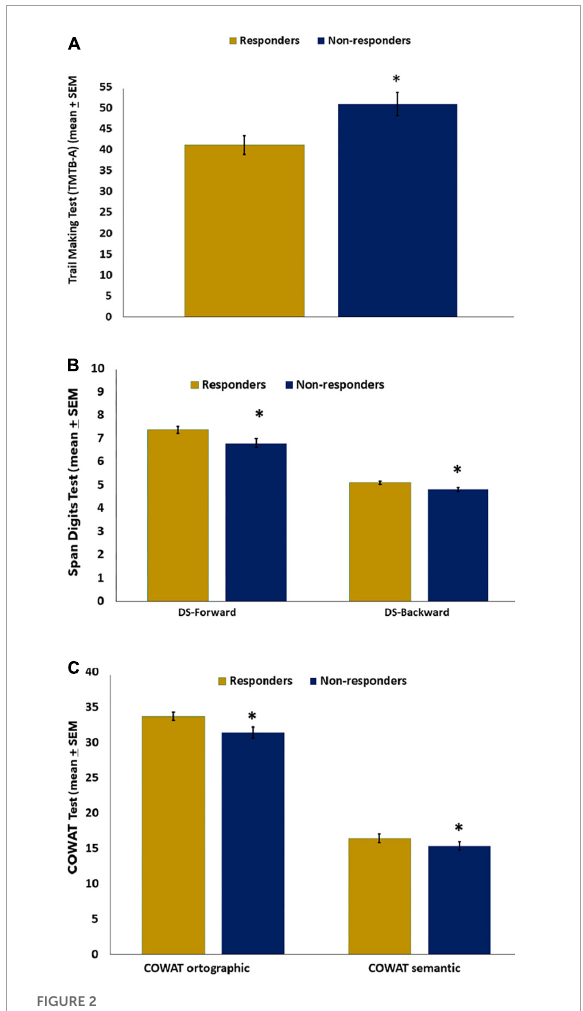
FIGURE2 Mean of cognitive performance in FM ( n = 68) according to responders and non-responders to CPM-test on the Trail Making Test (TMTB-A) (A) , (B) DS, Digits Spam (Forward–Backward), and (C) COWAT-orthographic; COWAT-semantic. The error bars indicate the standard error of the mean (SEM). Asterisks ( ∗ ) positioned above the bars indicate significant differences ( P < 0.05). All comparisons were performed by a hierarchical multilevel multivariate analysis of covariance (MANCOVA), followed by the Bonferroni correction for post hoc multiple